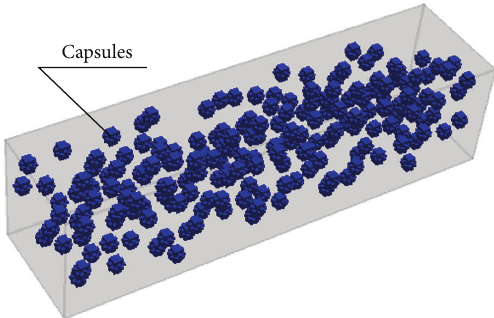
Figure 11: Standard beam (40mm × 40 mm × 160mm) containing capsules (the dosage of capsules is 5%).